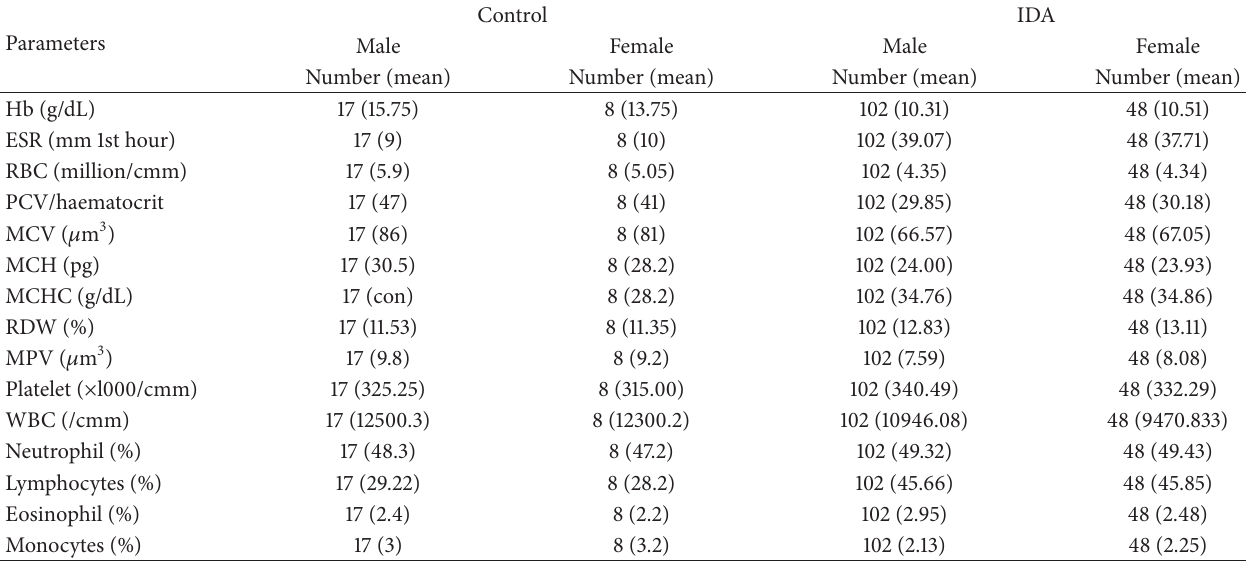
Table 3: Showing comparative hematological values between control and iron deficiency anemia (IDA) males and females. Parameters